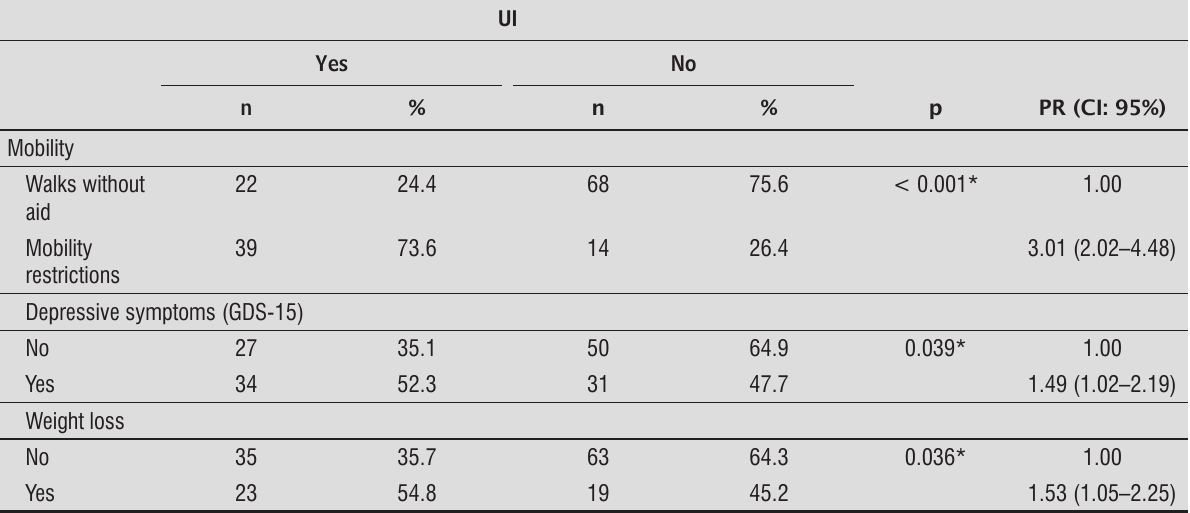
Table 3 - Association between UI and sex and those independent variables with p value under 0.20 – Natal (RN), 2014 UI Yes